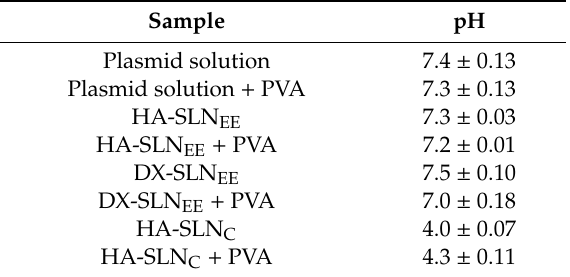
Table 4. pH measurements of plasmid solutions and vectors with and without PVA.